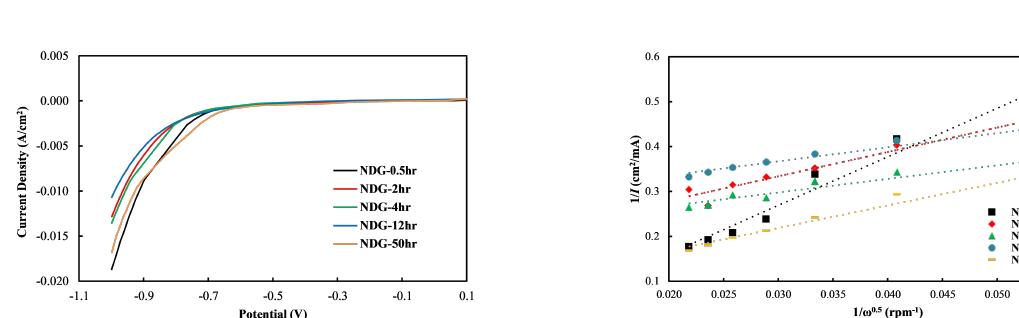
Fig. 8. Linear sweep voltammograms of all samples. voltammogram. (a) NDG-0.5hr; (b) NDG-2hr; (c) NDG-4hr; (d) NDG-50hr.